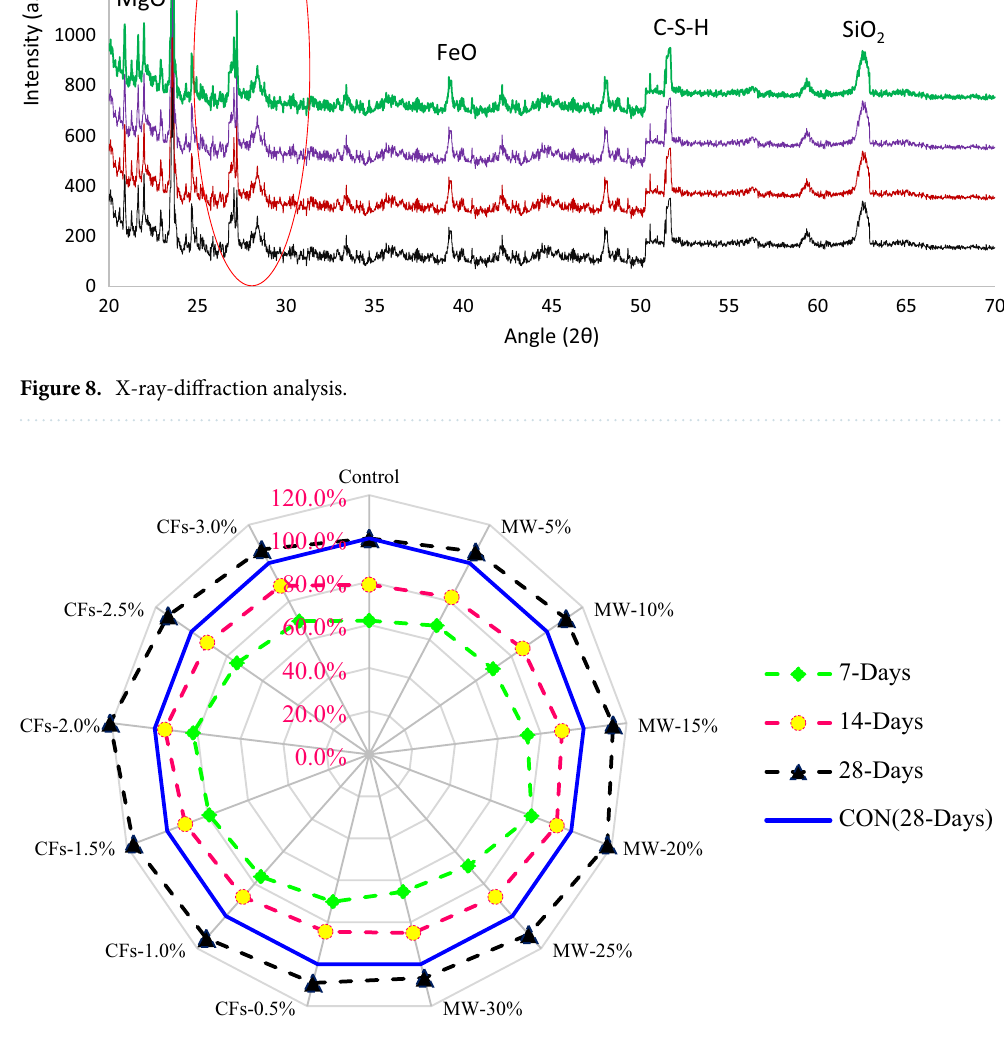
Figure 9. Relative analysis of compressive